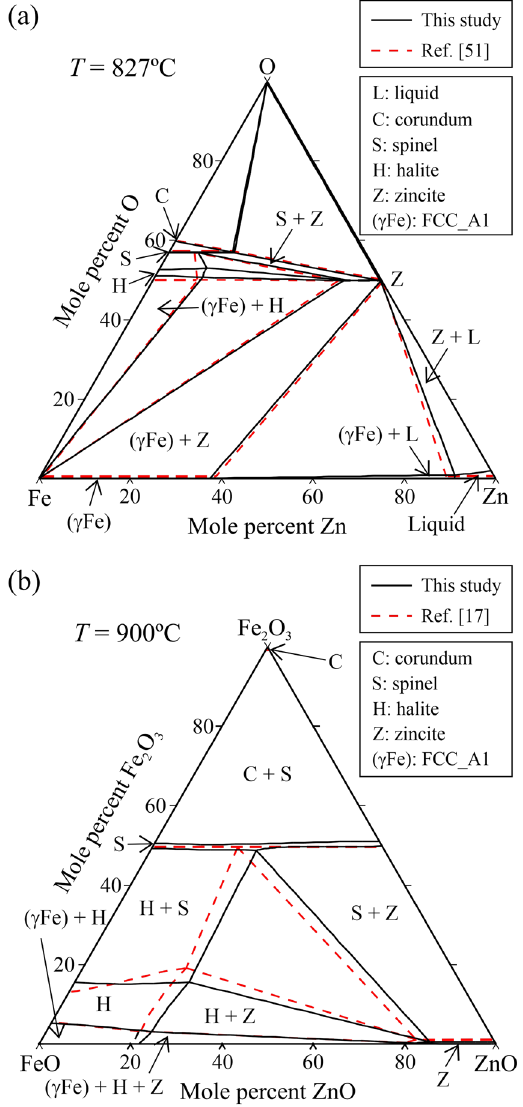
Figure 2: Calculated isothermal section diagrams: ( a ) Fe – Zn – O system at T = 827°C and ( b ) FeO – Fe 2 O 3 – ZnO system at T =